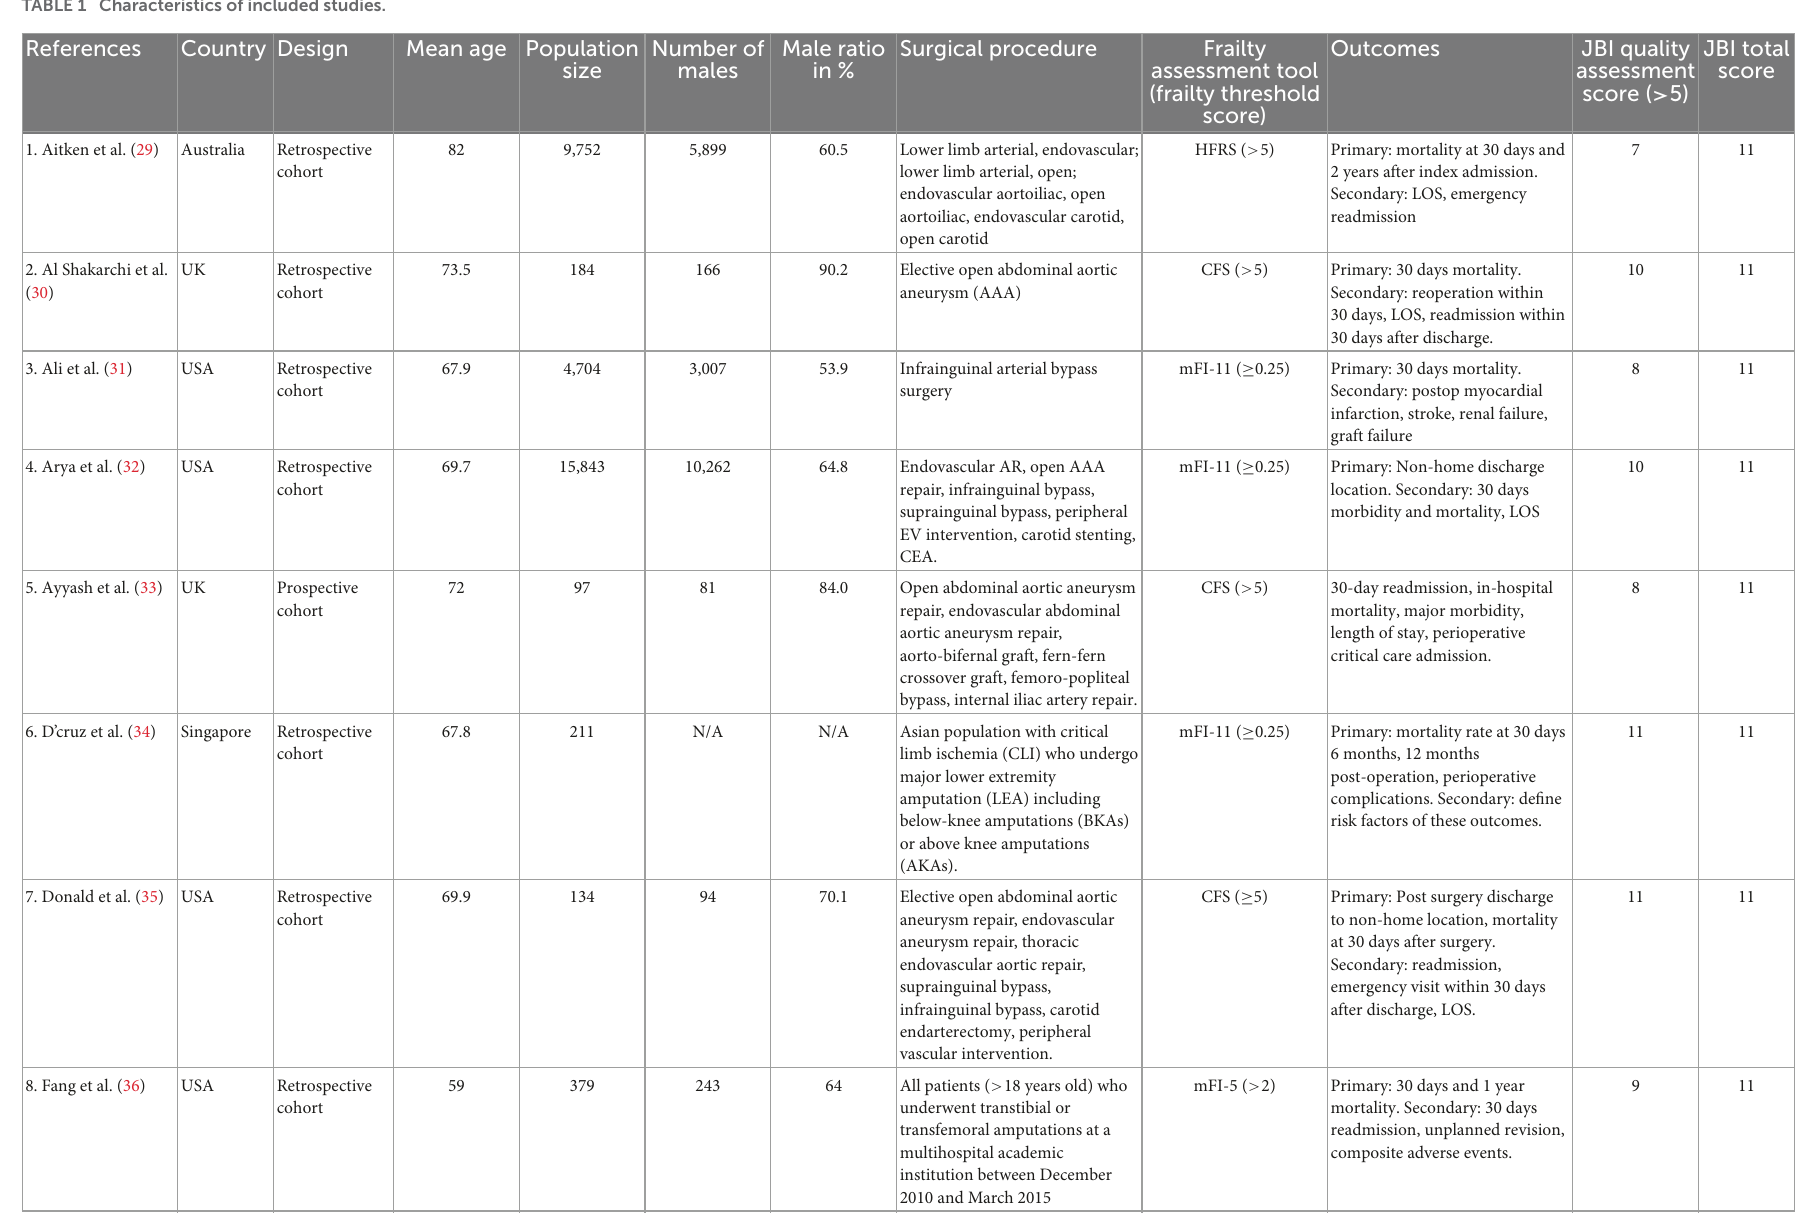
TABLE 1 Characteristics of included